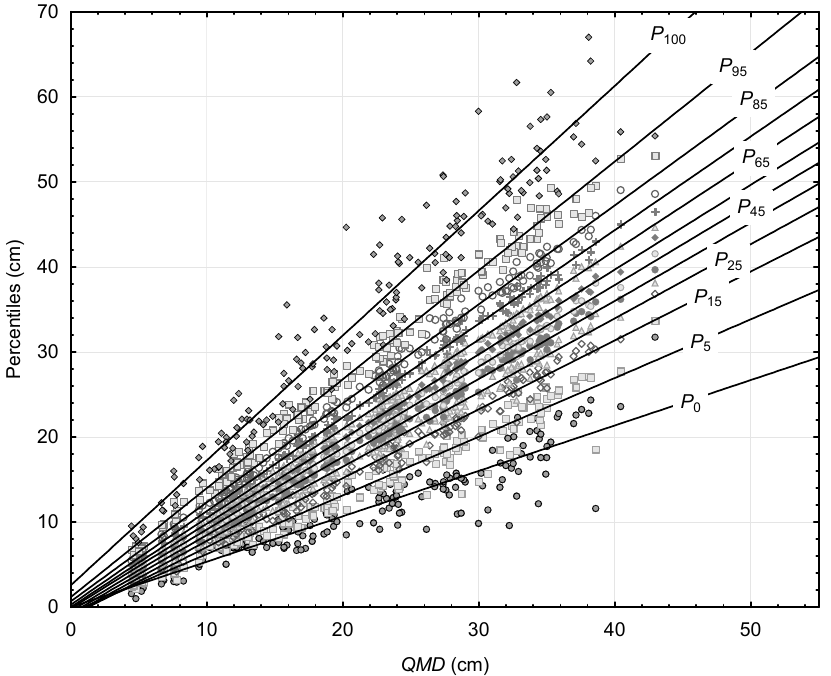
Figure 1. Relationship between ( a ) the first raw moment m 1 , ( b ) the second central moment m 2 and the quadratic mean diameter ( QMD ) of black alder stands.